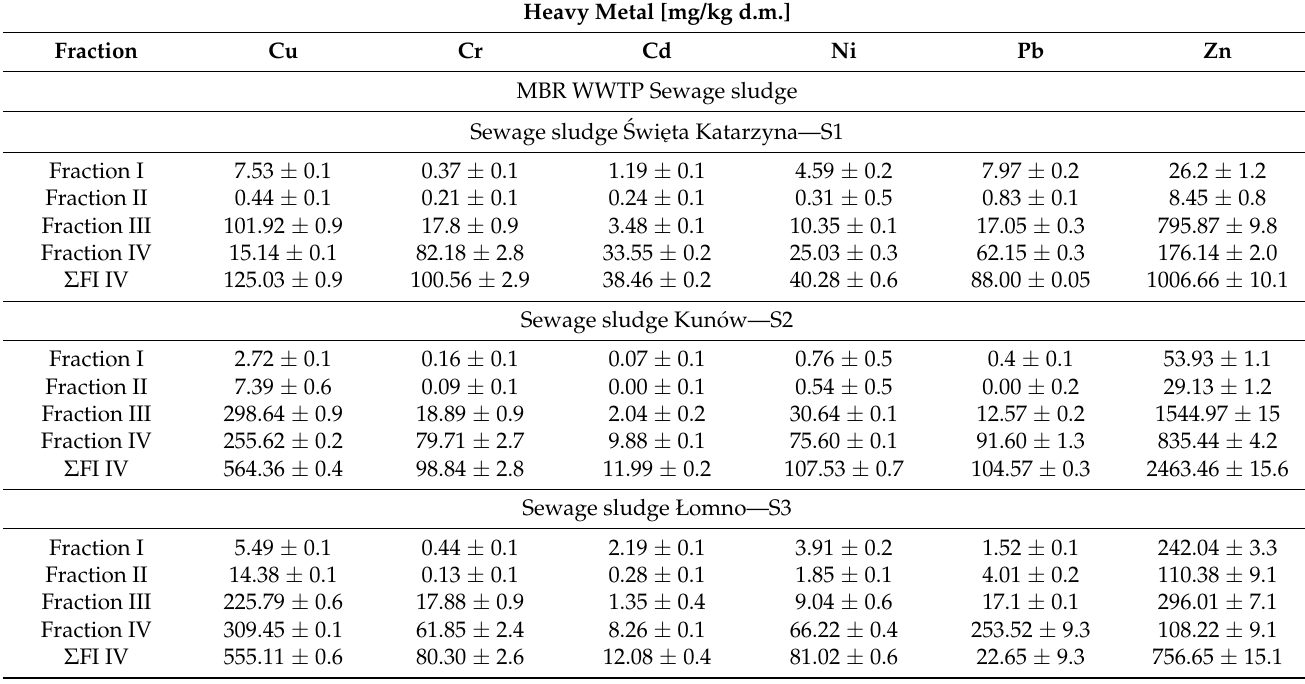
Table 7. Chemical speciation of heavy metals in sewage sludge, mg/kg d.m. (Heavy metal content with standard deviation calculated for 4 samples using Grubbs‘ statistical tests). Heavy Metal [mg/kg